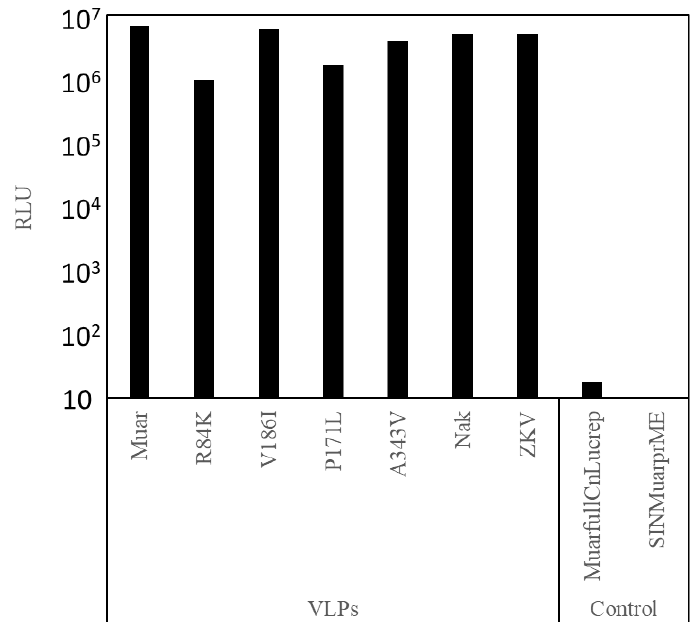
Figure 2. Production of nLuc-expressing virus like particles (VLPs). The nLuc-expressing VLP obtained from C6 / 36 cells electroporated with MuarfullCnLucrep RNA and sindbis virus replicon expressing prM-E genes were inoculated to Vero cells. Cells were lysed at 48 h post inoculation and then nano-luciferase activities were measured.